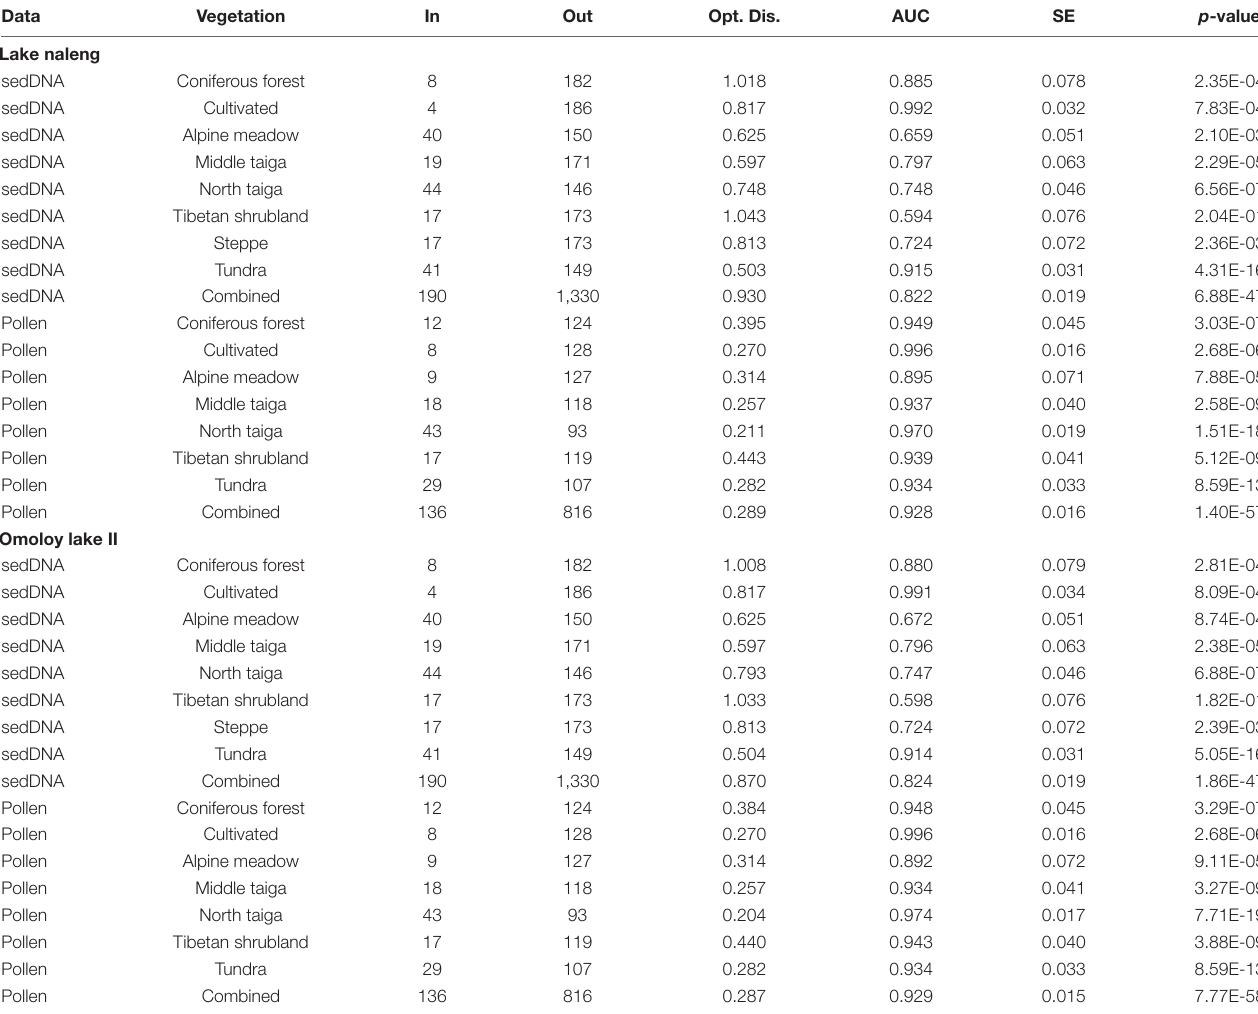
TABLE 1 | Overview of the receiver operating characteristic (ROC) curve analysis of the modern sedDNA and modern pollen training-sets for Lake Naleng and Omoloy lake II.